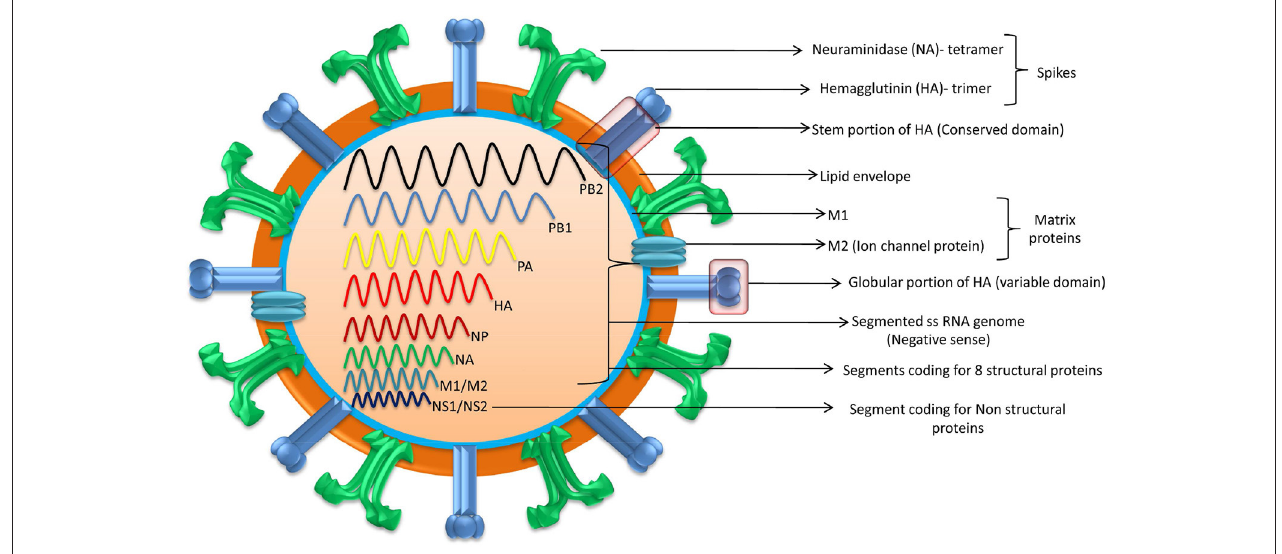
FIGURE 1 | Structure of Equine Influenza Virus. EIV is a segmented RNA virus possessing eight (single) segmented negative sense RNA strands. Segmented genome encodes eight structural proteins and at least two non-structural